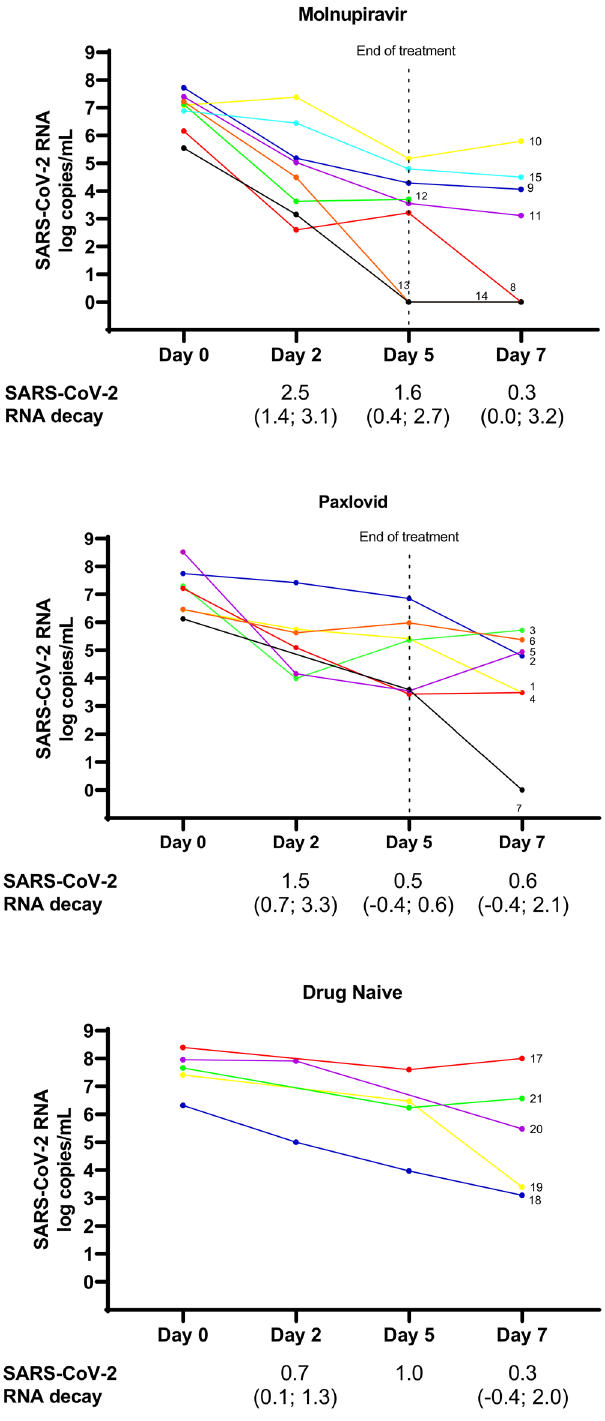
Fig. 1 SARS-CoV-2 RNA across time points in Molnupiravir-treated, Paxlovid-treated and Drug Naïve patients. Each patient is depicted by lines of different colors. Day 2 is missing for ID7, ID17, and ID21. Day 5 is missing for ID20. Day 7 is missing for ID12 and ID13. SARS-CoV-2 RNA decay from Day 0 to Day 2, from Day 2 to Day 5 and from Day 5 to Day 7 is expressed as log median